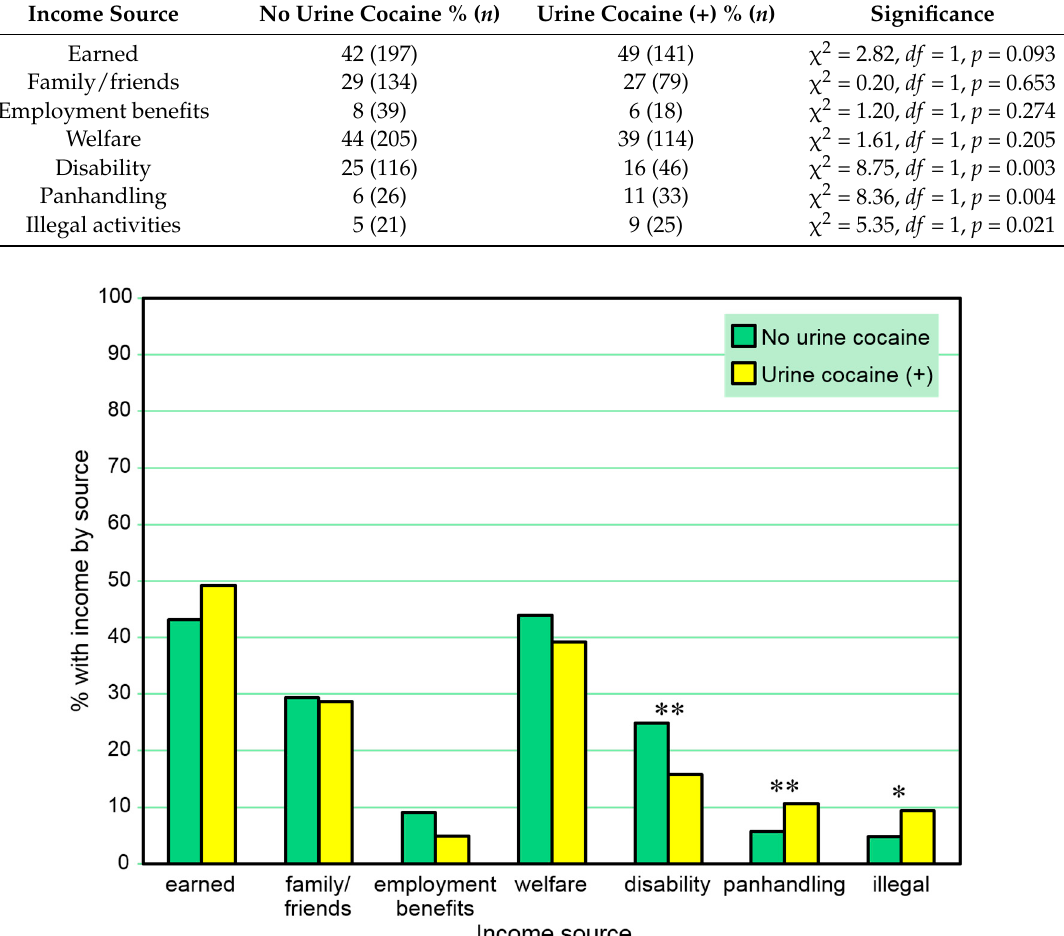
Figure 2. Proportions with 30-day income sources among those with and without a positive urine cocaine test in the same month. * p ≤ 0.05, ** p ≤ 0.01. Table 3. Total amounts earned from 30-day income sources across three interviews among those with and without a positive urine cocaine test at any time